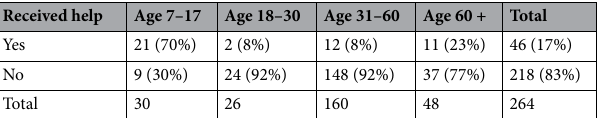
Table 4. Number of participants in four age groups that received help from others during the test.